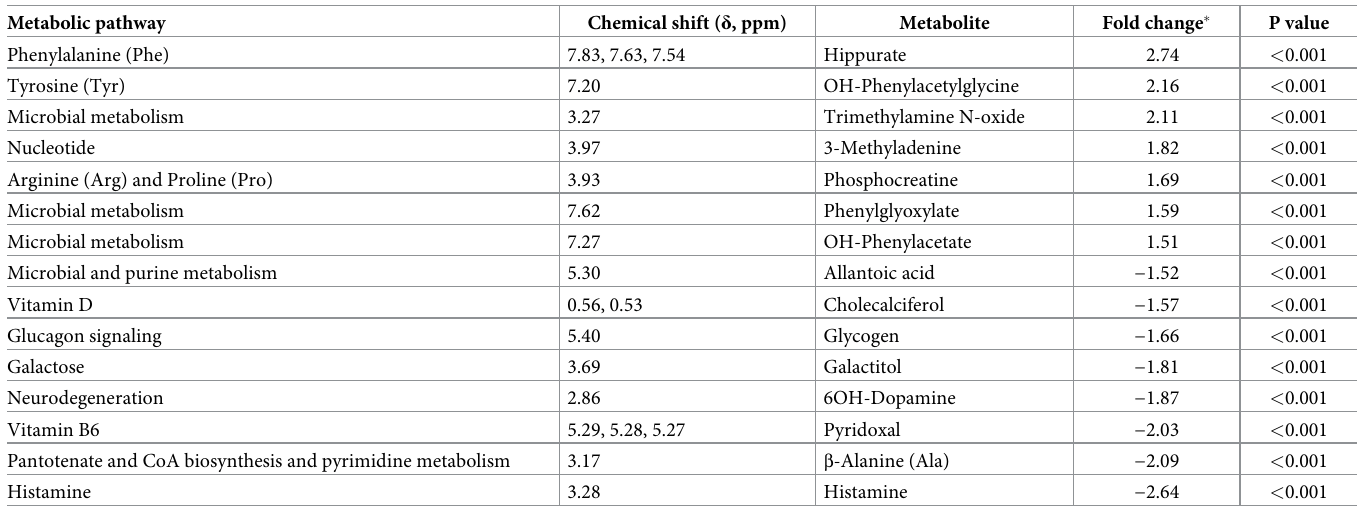
Table 2. Selected metabolites contributing to the classification of the urine metabolome of thermoneutral and heat-stressed lactating dairy does. Metabolic pathway Chemical shift ( δ , ppm)